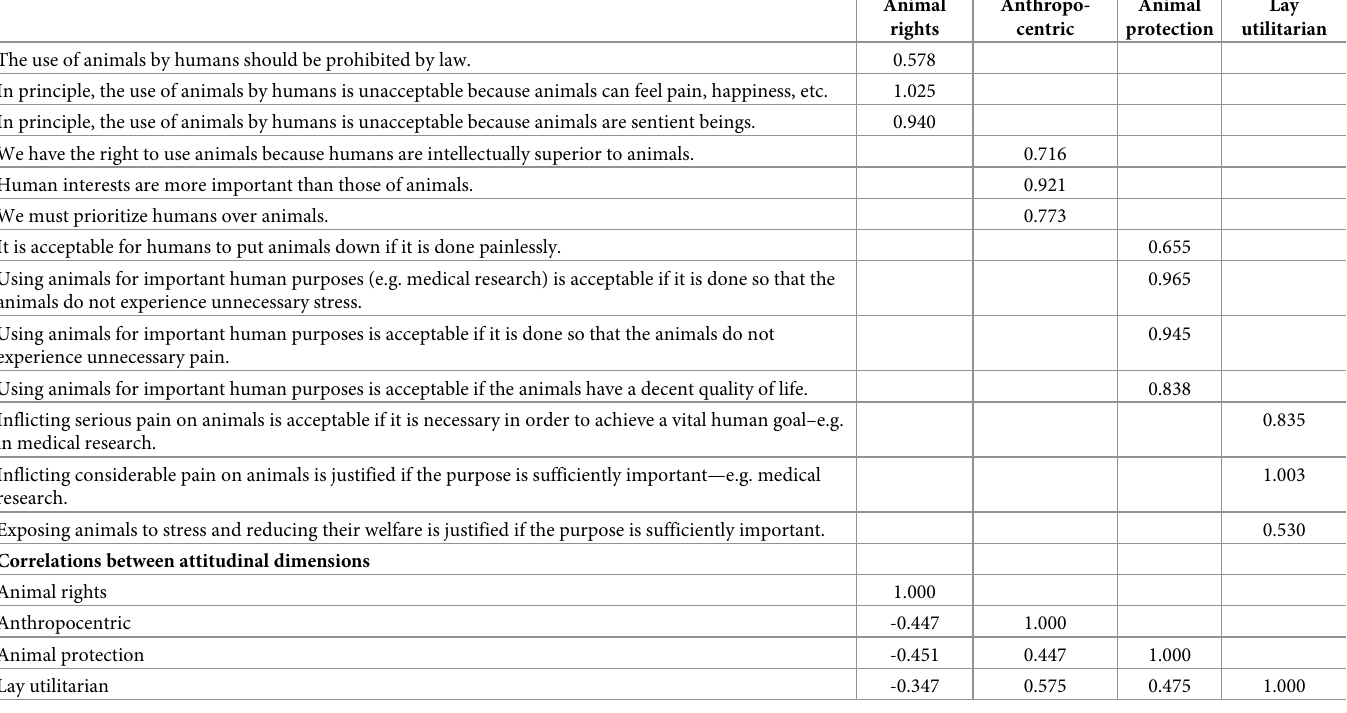
Table 1. Factor structure of the multidimensional measure of animal ethics orientations—results from explorative factor analysis in Study 1 (N =